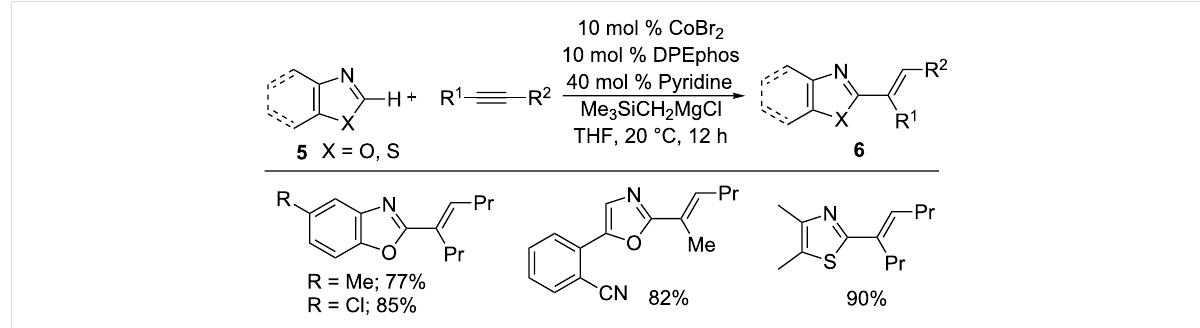
Scheme 6: Co-catalyzed addition of azoles to alkynes.